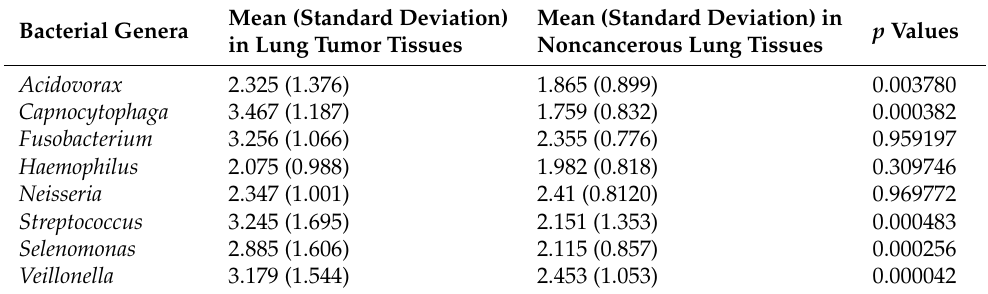
Table 1. DNA abundances of eight bacterial genera in tissues specimens of 58 lung cancer cases.